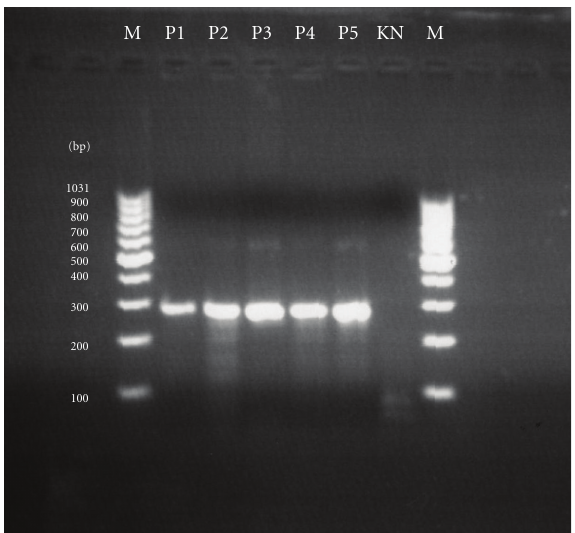
Figure 10: The PCR test confirming the presence of bacilli in the studied material (M: the size marker, P1: a sample from the carrier placed on the frame of the turner, P2: a sample from the carrier placed on the shovels of the turner; P3: a sample from the carrier placed in the sludge pile, P4: Salmonella Agona, P5: Salmonella Braenderup H9812 (P4 and P5: positive control), KN: negative